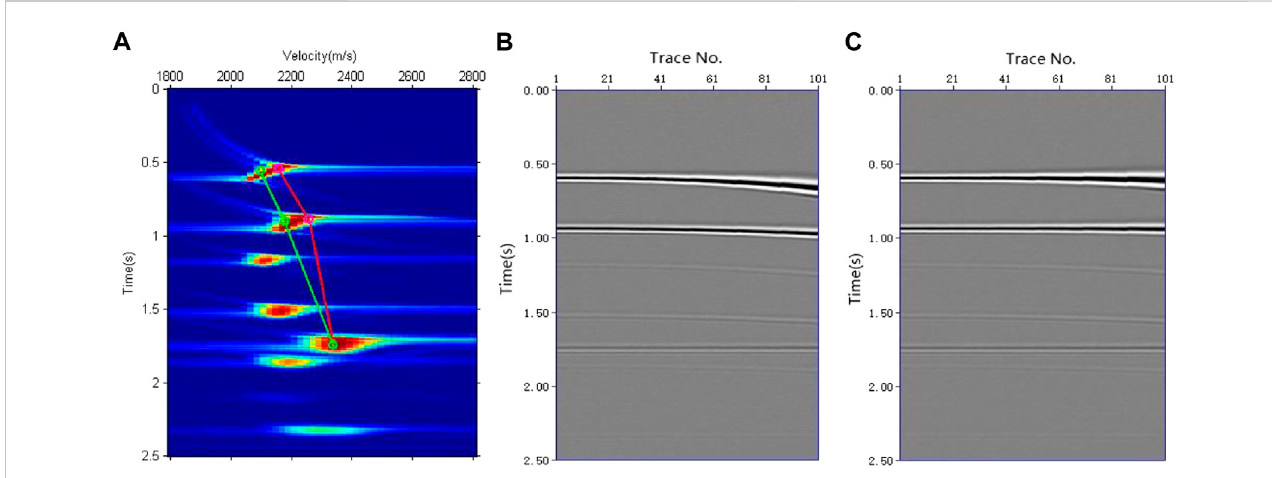
FIGURE 5 Velocity picking and normal move out (NMO) correction results. (A) Velocity picking results, where the red line is the conventional k-means clustering method and the green is the weighted k-means clustering method. (B) NMO correction results while applying velocity picked by conventional k-means clustering. (C) NMO correction results while applying velocity picked by weighted k-means